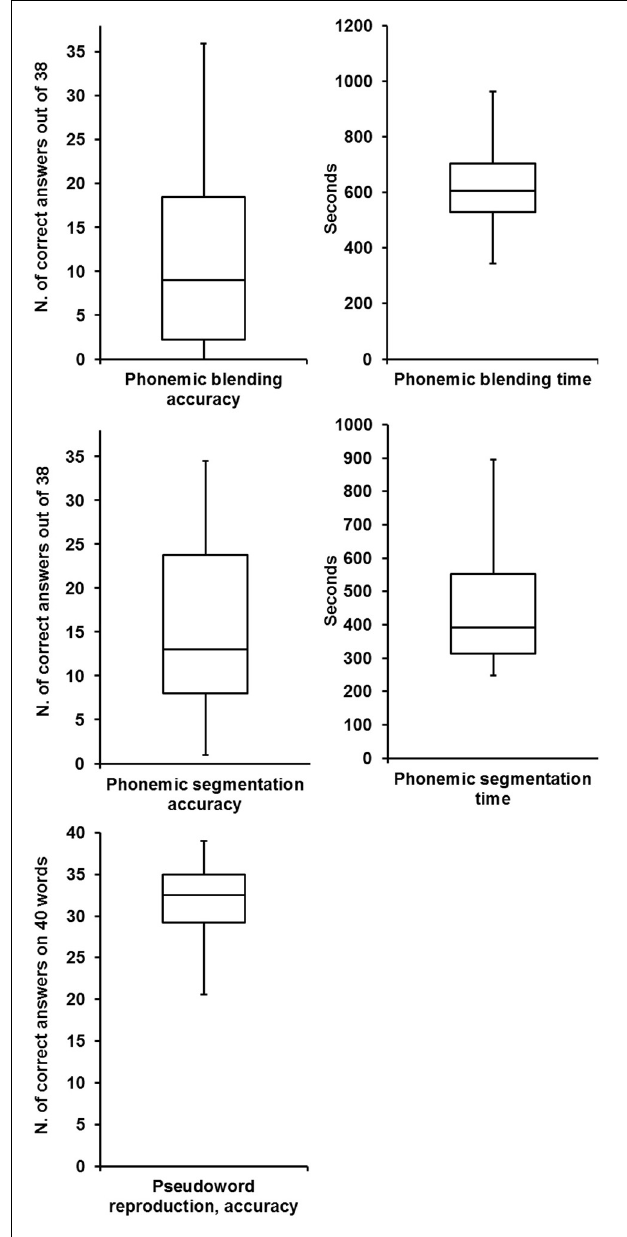
FIGURE 2 | Box plots of the phonological awareness